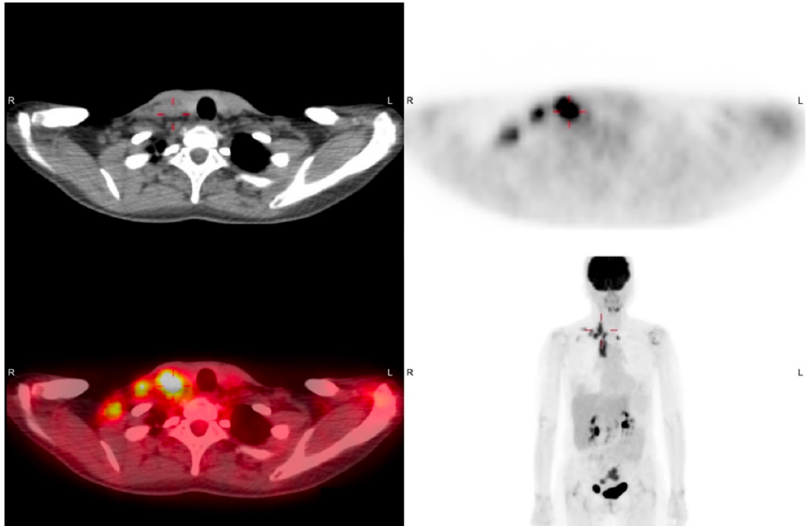
Figure 2. Positron emission tomography/computed tomography revealed the increased radioactivity uptake in the right neck level V and right pelvic adnexa regions.